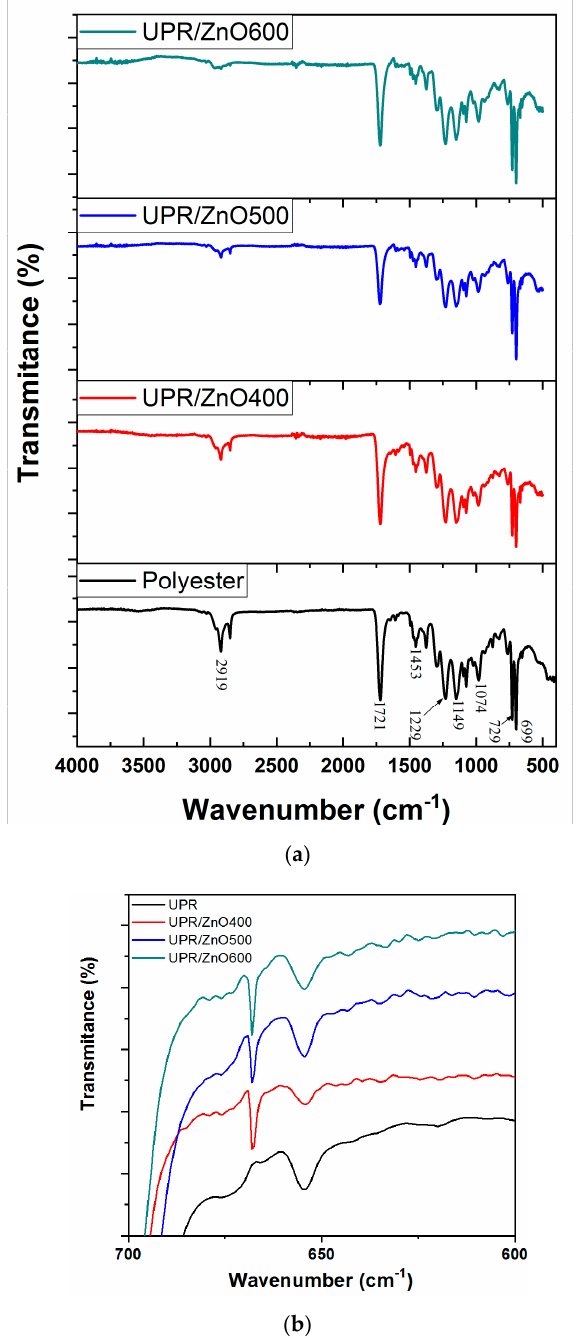
Figure 2. FTIR from ( a ) unsaturated polyester resin (UPR) and nanocomposites and ( b ) a close view from 700 to 600 cm − 1 .